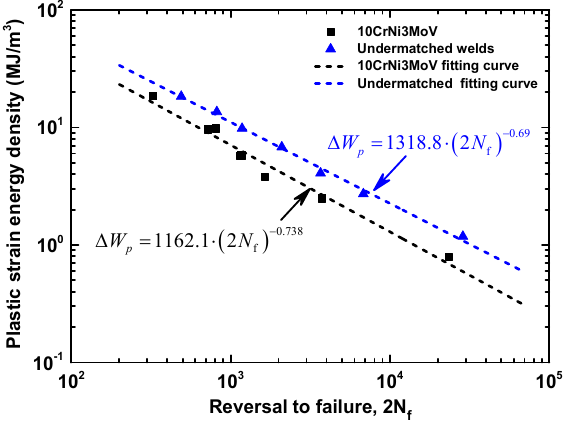
Figure 11. Comparison of Plastic strain energy density ∆ W p between 10CrNi3MoV high strength steel and undermatched welds.